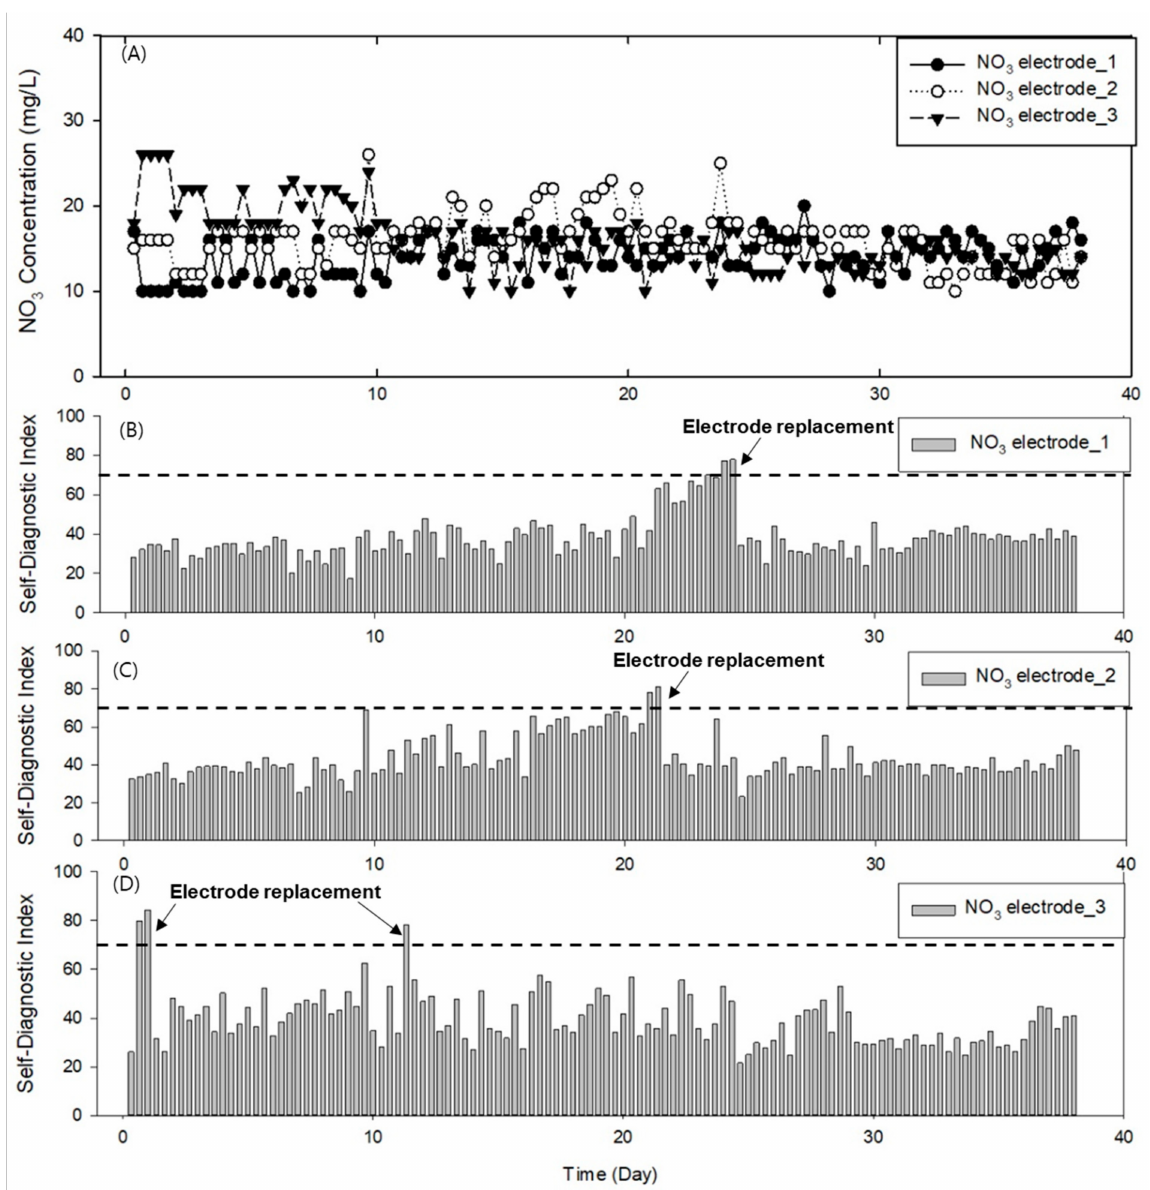
Figure 6. Results of monitoring NO 3 − concentration in laboratory setting: ( A ) NO 3 − concentrations provided by each electrode; ( B – D ) changes in SDI and electrode replacement histories of ( B ) electrode 1, ( C ) electrode 2, and ( D ) electrode